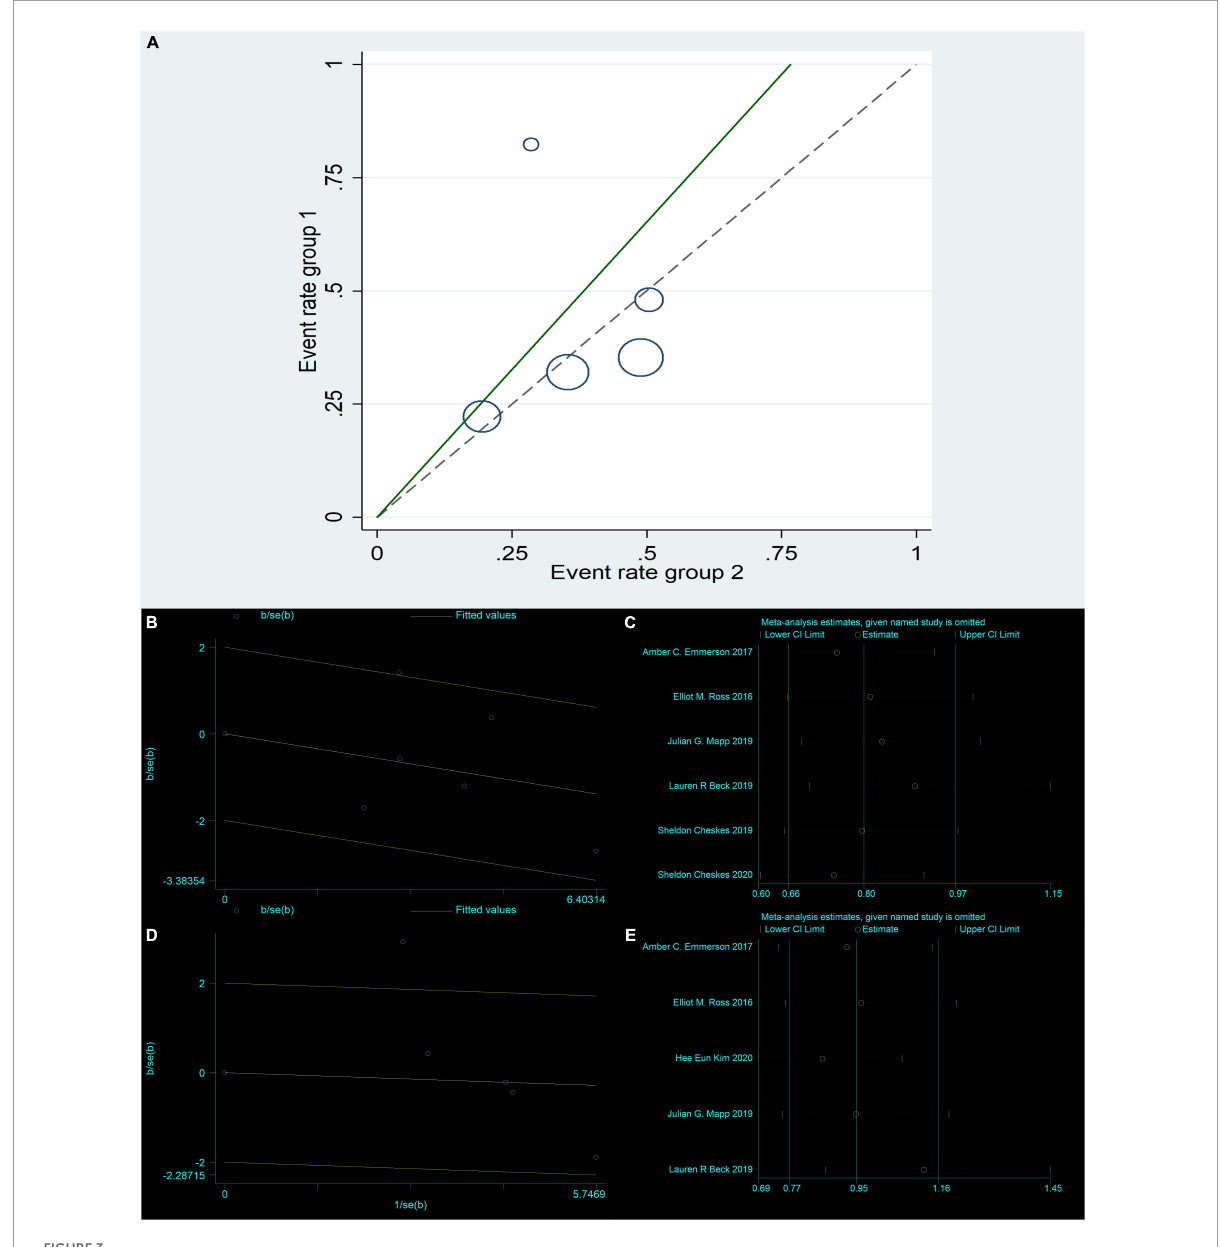
FIGURE3 Return of spontaneous circulation: Radial Plot (B) ; Sensitivity analysis (C) . Survival to hospital admission: L’Abbe Plot (A) ; Radial Plot (D) ; Sensitivity analysis (E) .